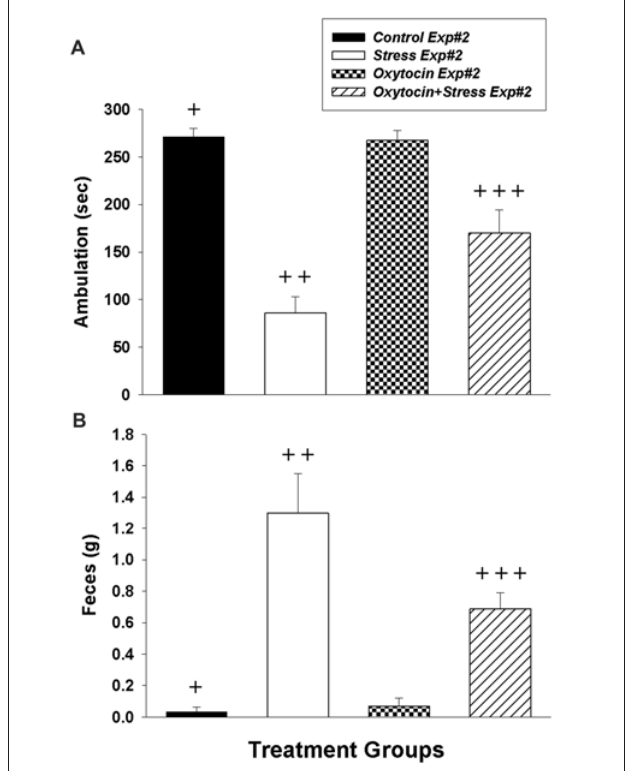
FIGURE 2 | Impact of intranasal oxytocin administered 1 h before (Experiment #2) daily foot shock sessions (3 days, 40 shocks/day, 8 mA/shock). (A) Ambulation (inverse of freezing behavior) during 5 min re-exposure to the fear conditioning chamber 7 days after the last day of foot shock. (B) Fecal production (colonic motility) during the same 5 min re-exposure. Data analyzed by two-way ANOVA followed by post hoc Tukey’s HSD test for between-group comparisons. + Significantly different than Stress Exp # 2 and Oxytocin+Stress Exp # 2 ( p < 0.05). ++ Significantly different than Control Exp # 2, Oxytocin Exp#2 and Oxytocin+Stress Exp#2 ( p < 0.05). +++ Significantly different than Stress Exp # 2, Oxytocin Exp # 2